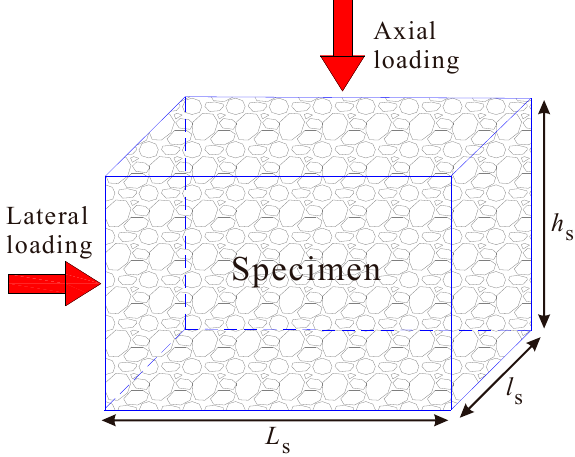
Figure 8. Loading direction and dimensions of the specimen.